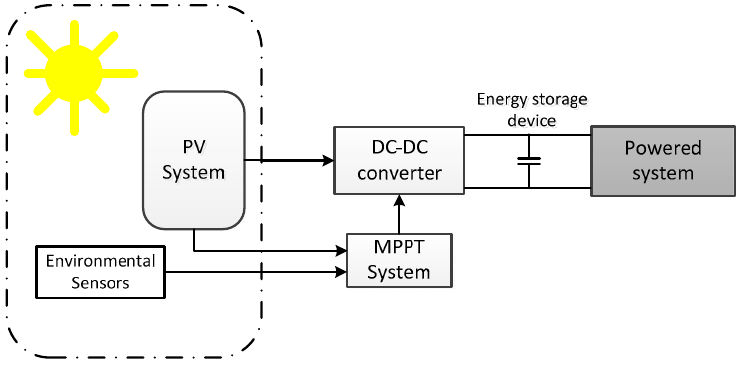
Figure 8. Generic solar energy harvesting block diagram.